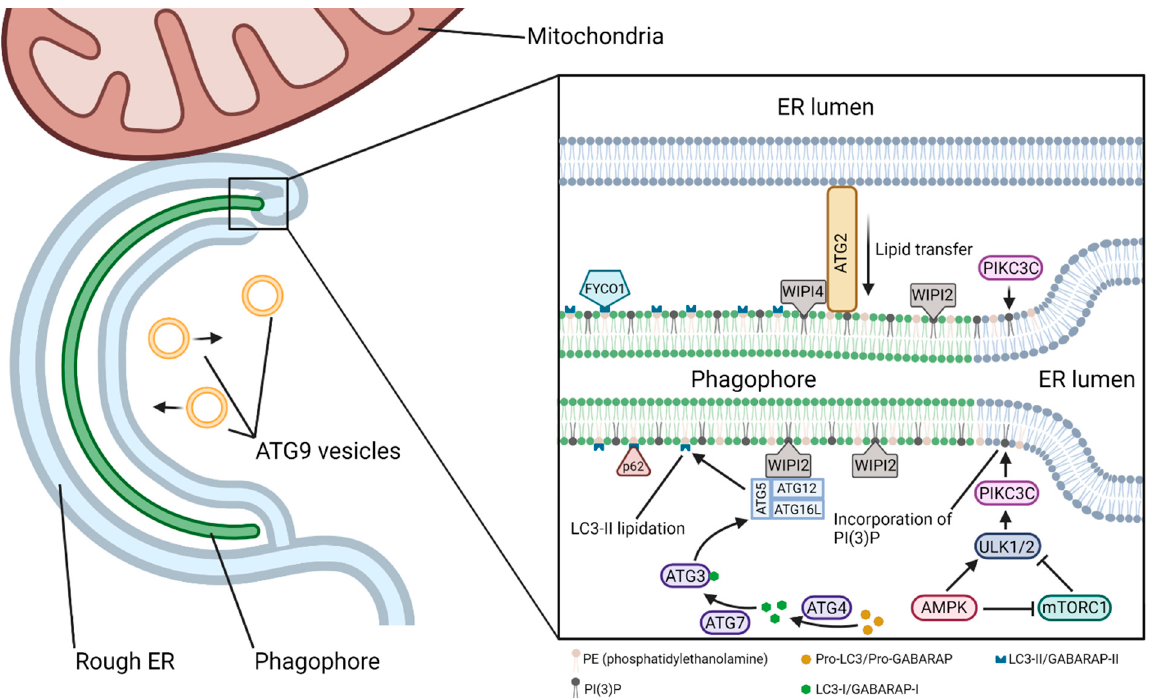
Figure 5. Elongation of the phagophore. WIPI proteins are recruited to the phagophore membrane by PtdIns(3)P, where they act as an adaptor for a variety of proteins that shape and modify the phagophore. The membrane sources that feed the growing phagophore can be varied. Direct extrusion of the ER or other membranes may contribute to phagophore growth. Additionally, ATG2 may transfer lipids from one membrane to another, such as from the ER or ATG9 vesicles (not shown). ATG9 vesicles may also donate lipids through a kiss-and-run mechanism, though no ATG9 proteins are transferred to the phagophore. Pro-LC3 in the cytosol is converted by ATG4 into LC3-I, which is transported to ATG3 by ATG7. ATG3 brings LC3-I to the ATG12–ATG5–ATG16L1 complex, which processes it into LC3-II and conjugates it to PE (phosphatidylethanolamine) in the phagophore membrane. LC3-II then acts as an adaptor for various effector proteins.